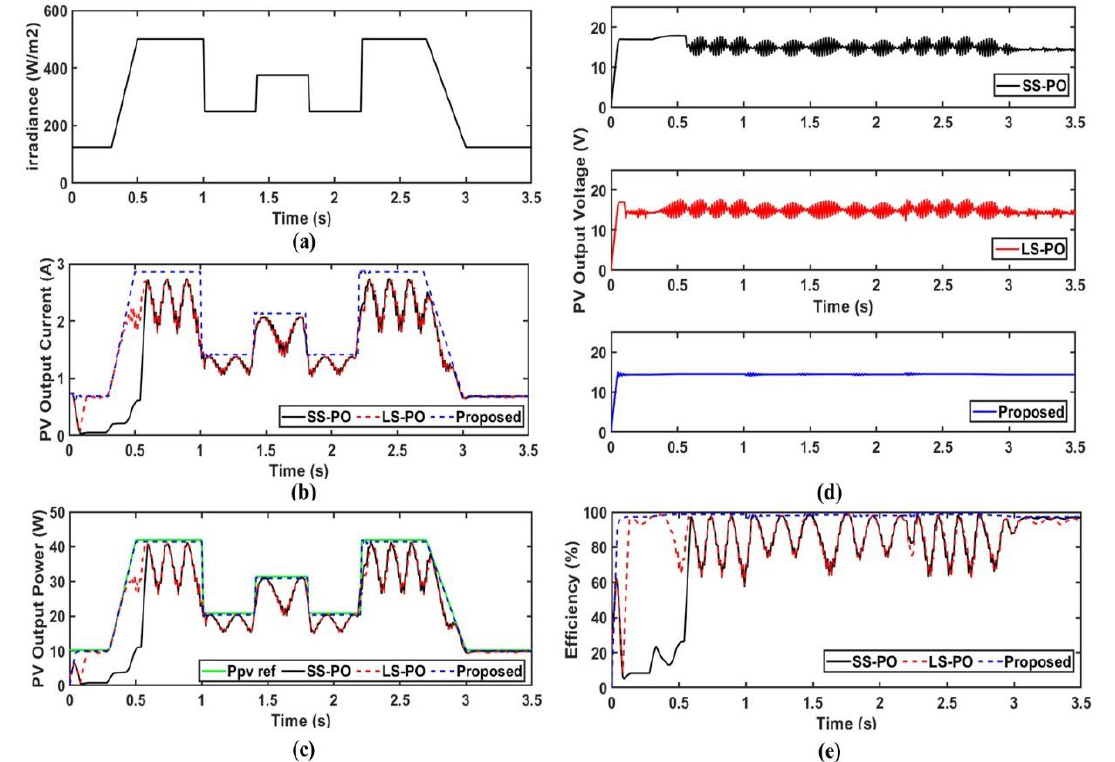
Figure 11. PV results: ( a ) Ropp irradiance profile. ( b ) PV output current. ( c ) PV output power and ( d ) PV output voltage. ( e ) System-tracking efficiency.